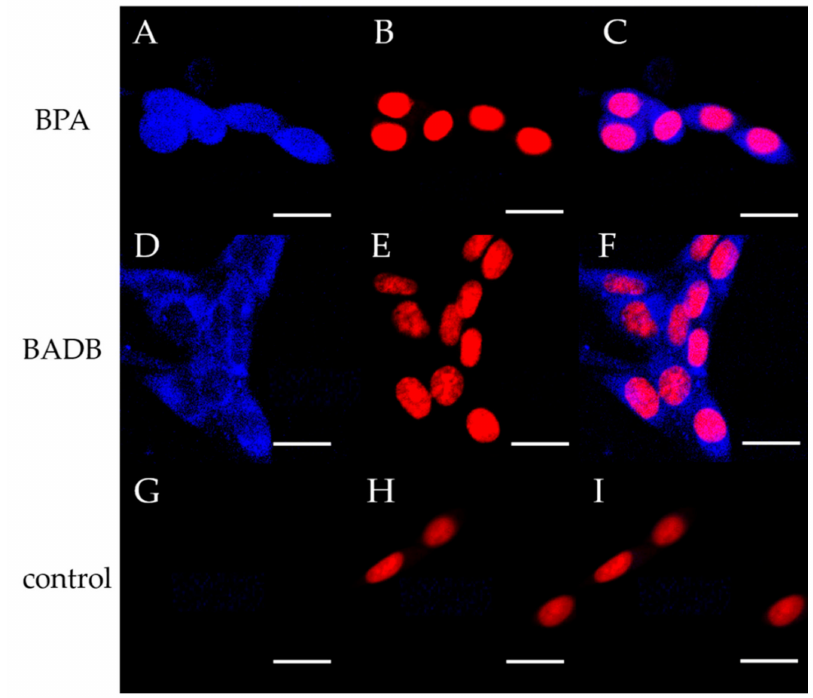
Figure 3. The micro-distribution of BPA and BADB in F98 cells. Scale bar = 20 µ m ( A ): Fluorescence (ex:405nm)microscopyimageshowingthedistributionofBPAovera20-minperiodusingDAHMIasthe boron sensor. ( B , E , H ): Nucleus labeled with DRAQ5 TM . ( C ) Merged image of ( A , B ). ( D ): Fluorescence (ex: 405 nm) microscopy image showing the distribution of BADB over a 20-min period using DAHMI as the boron sensor. ( F ): Merged image of ( D , E ). ( G ): Fluorescence (ex: 405 nm) microscopy image showing the distribution of medium without boron over a 20-min period using DAHMI as the boron sensor. ( I ) Merged image of ( G , H ).